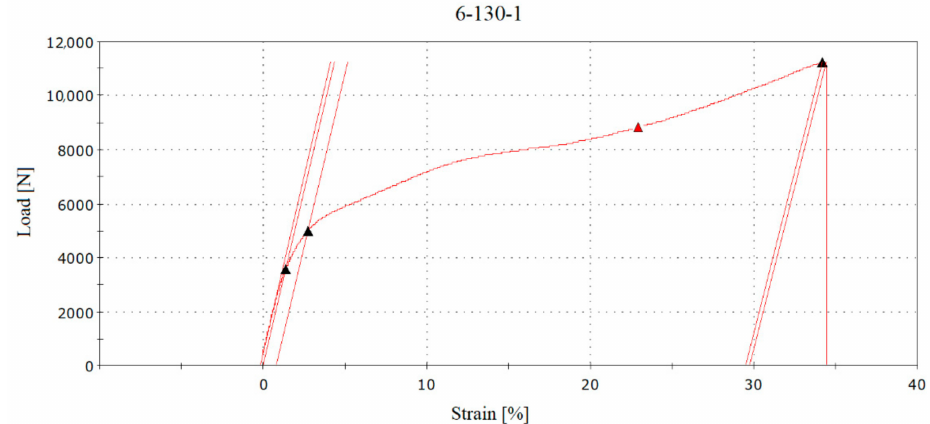
Figure 12. The point of interruption (red triangle) of the RFID tag transmission at approximately a